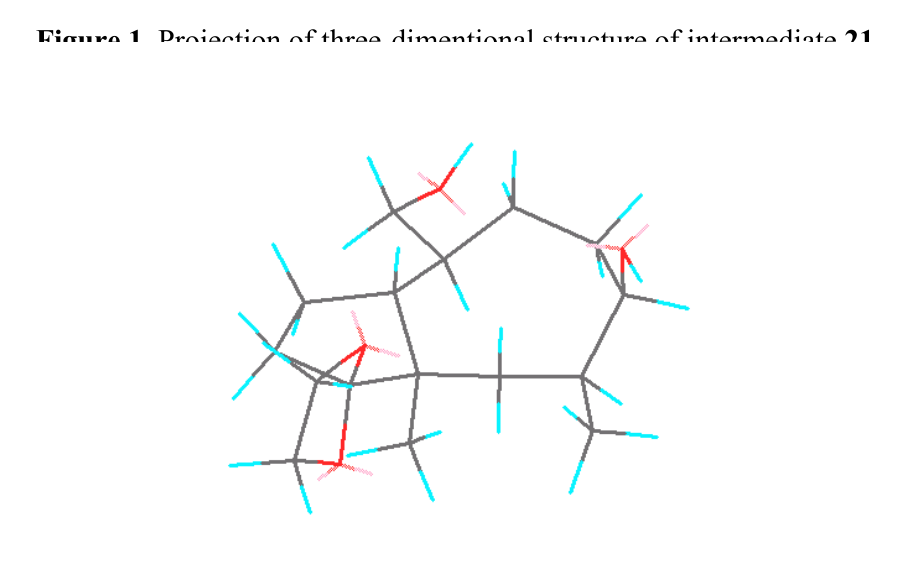
Figure 1. Projection of three-dimentional structure of intermediate 21